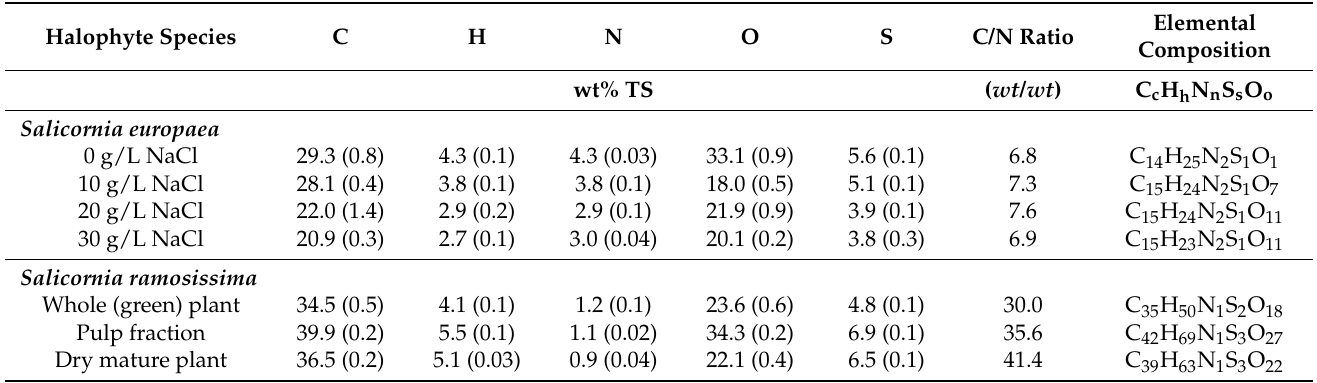
Table 4. Elemental analysis, C/N ratio and overall composition of Salicornia samples, standard deviation of triplicates in parentheses.